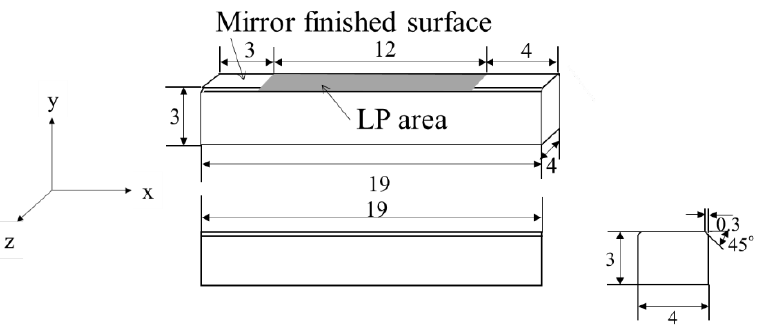
Figure 1. Shape and dimensions of bending test specimen (unit: mm).